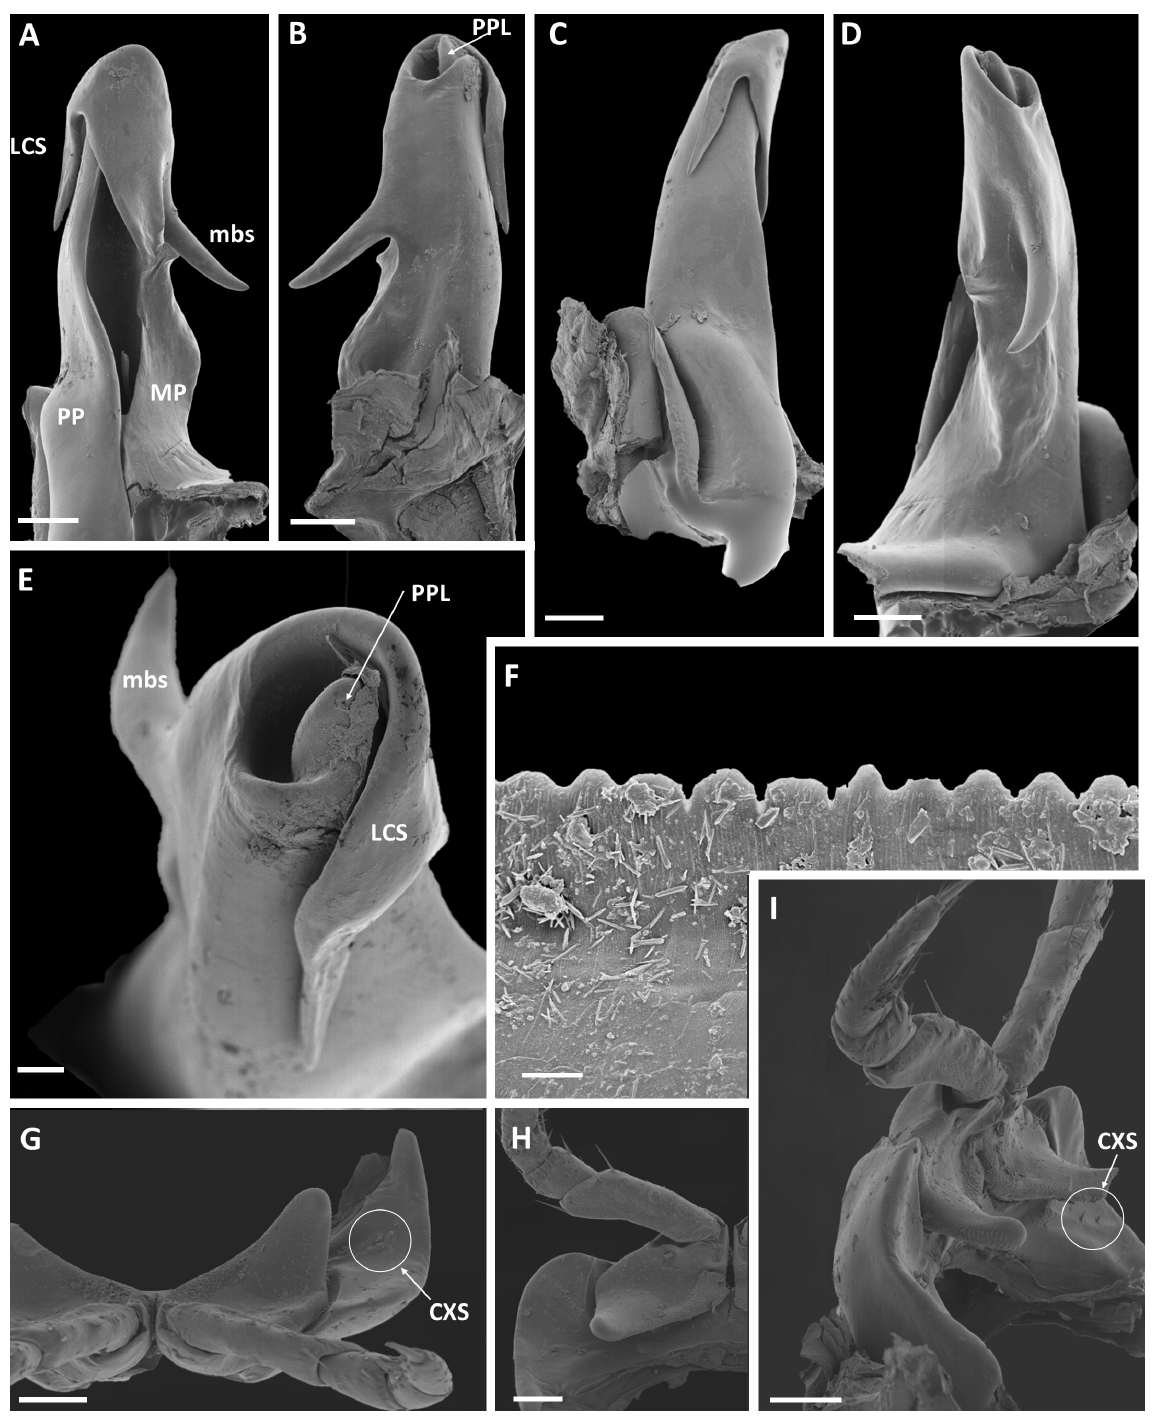
Fig. 50. Praludivera paralellamella gen. et sp. nov., holotype, ♂ (VMNH110633), A–E . Left gonopod coxa. A. Anterior view. B. Posterior view. C. Lateral view. D. Mesal view. E. Oblique apical view. F . Midbody dorsal limbus. G–I . First pair of legs (right prefemoral lobe broken). Abbreviations: CXS = coxosternal setae; LCS = lateral coxal spine; mbs = metaplical mesad-basal spine; MP = metaplica; PP = proplica; PPL = proplical lobe. Scale bars: A–D, G–I = 0.2 mm; E = 0.05 mm; F = 0.01